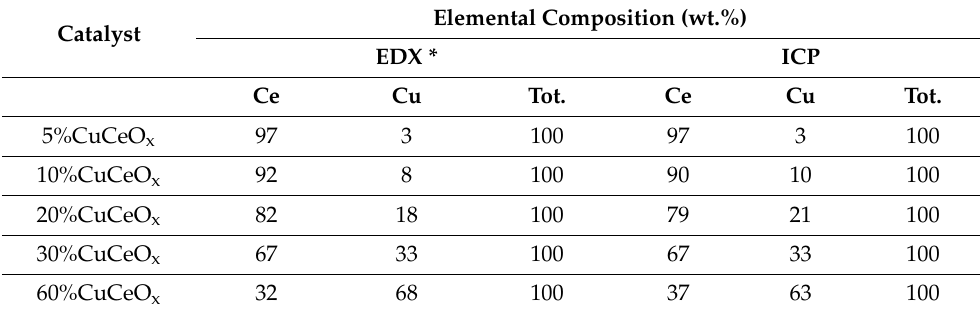
Table 2. EDX and ICP analysis of the CuCeO x catalysts: the elemental content is expressed in percentage of Ce and Cu with respect to the total amount of cations (Ce + Cu). Elemental Composition (wt.%) Catalyst EDX * ICP Ce Cu Tot. Ce Cu Tot.